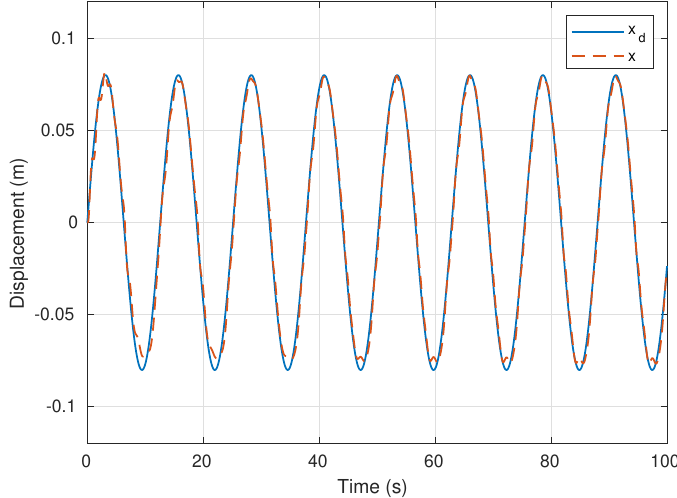
Figure 12. Sinusoidal wave trajectory tracking performance with feedforward-feedback con- trol